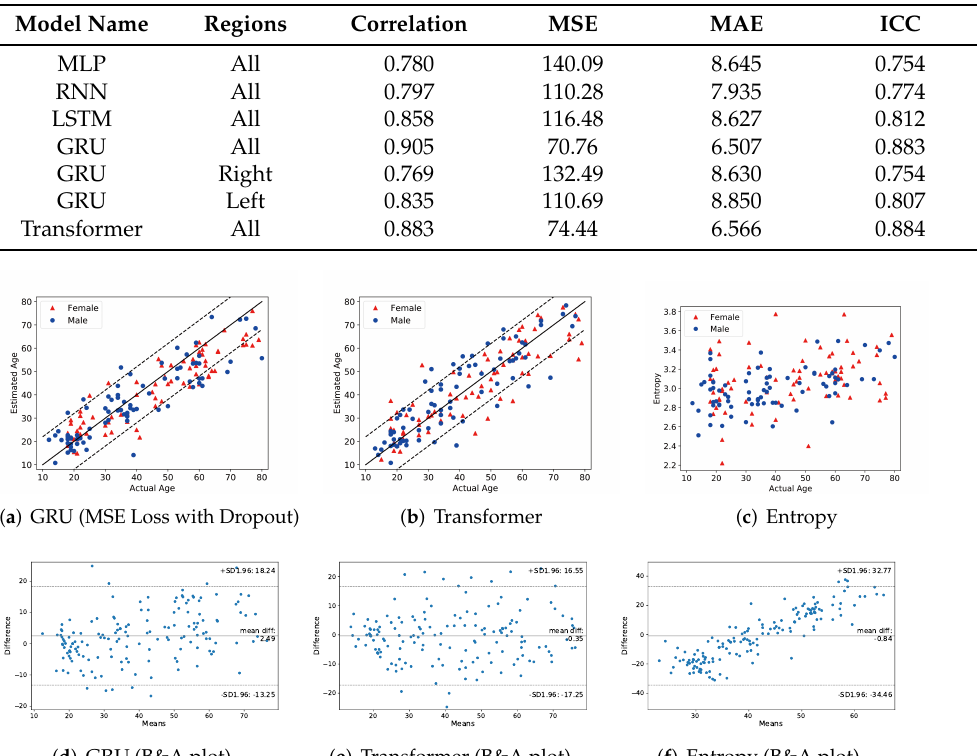
Table 3. Correlation between the estimated age and the actual age on the test dataset.